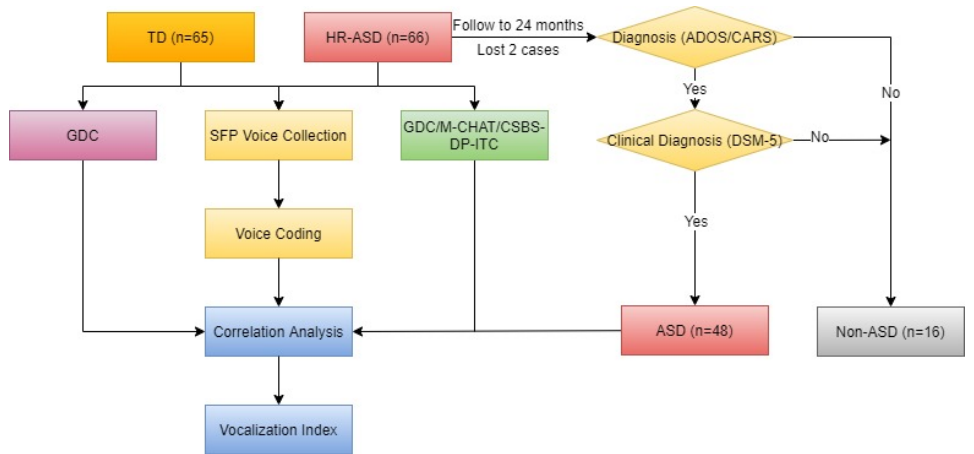
Figure 2. Flow chart of ASD vocalization experiment.